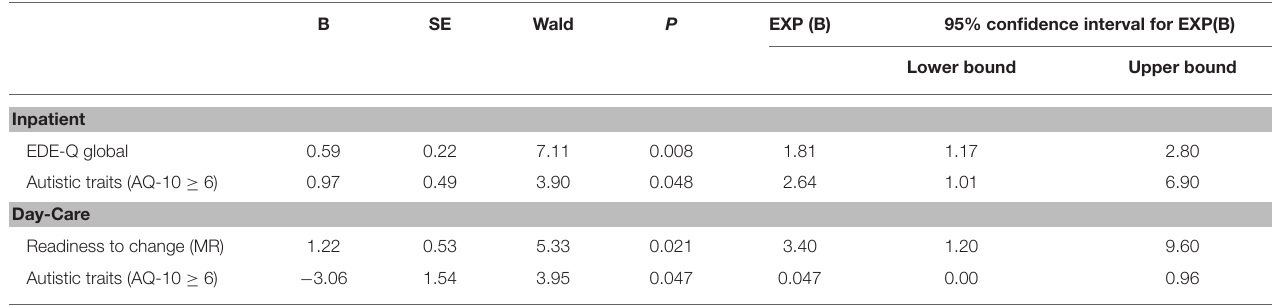
TABLE 4 | Significant predictors of a clinically significant change in eating disorder symptoms (EDE-Q Global score) in IP and DC.